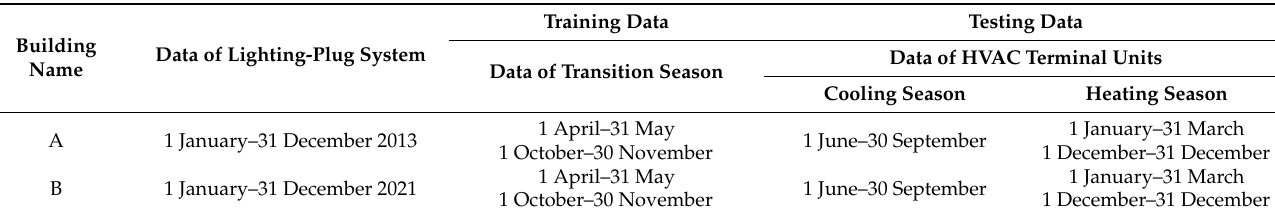
Table 6. Selected electrical input data from two buildings studied in Shanghai.